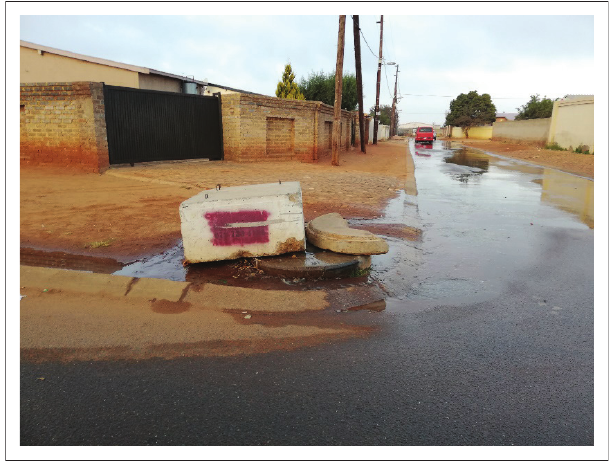
Source : Photo courtesy of Mamorwadi J. Kemp (27 June 2019) FIGURE 5: Leaking sewerage drain in Alabama Street, Extension 16 in Protea Glen.